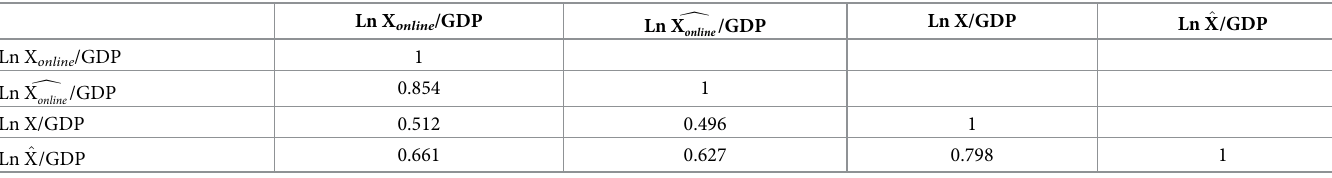
Table 4. Correlation between observed and predicted trade flows.